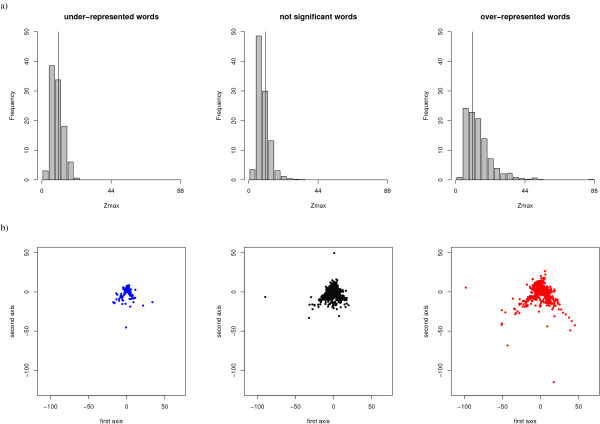
Sequential specificity of the three statistical word types of Wset≥30. a) Intra-word analysis: distribution of the Zmax. The vertical line corresponds to a threshold of 10. b) Inter-word analysis: Sammon's map computed from the Euclidean distance between Z-scores. All the points are subjected to the same projection and plotted on distinct plots.